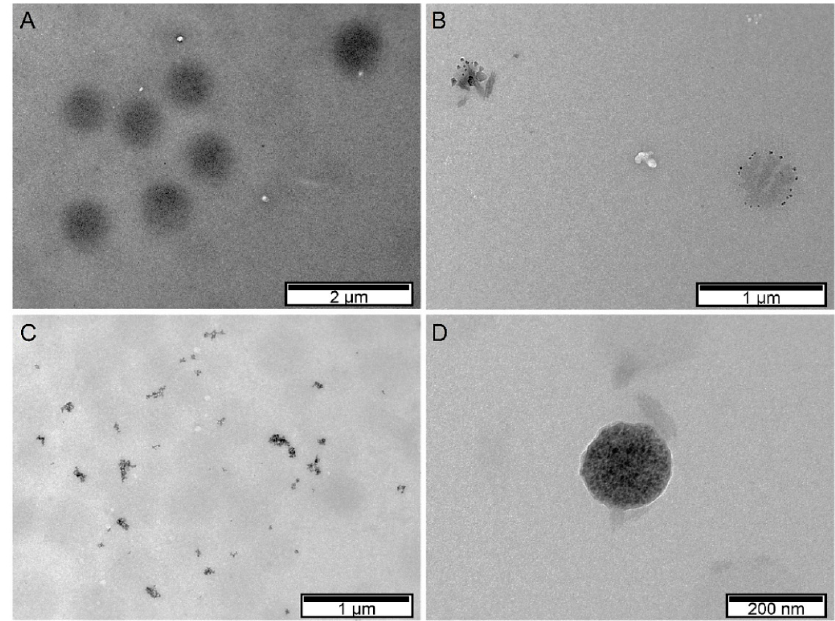
Figure 2. TEM images of bare PNIPAAm microgels ( A ), hybrid PNIPAAM microgels incorporated with bare Fe 3 O 4 nanoparticles (NPs) ( B ), with Fe 3 O 4 -OA NPs ( C ), and with Fe 3 O 4 -DMSA NPs ( D ). (OA: Oleic acid; DMSA: Dimercaptosuccinic acid).